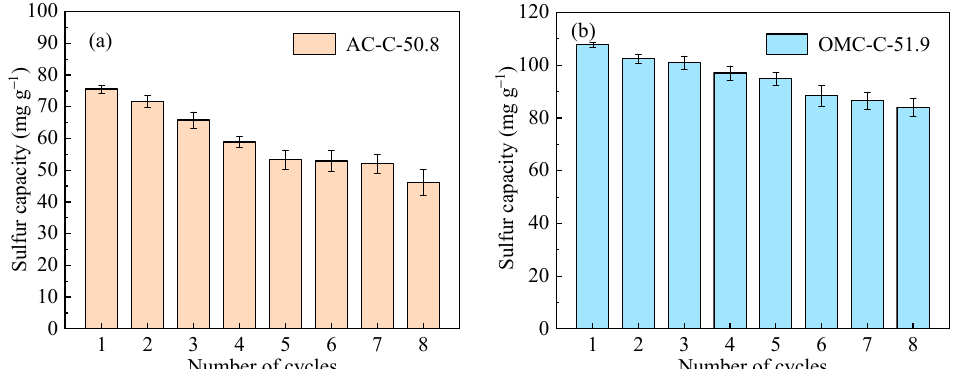
Figure 8. Sulfur capacity of the adsorbent over eight adsorption-regeneration cycles. ( a ) AC-C-50.8; ( b ) OMC-C-51.9. Adsorption conditions: 2.5 g of adsorbents, 1500 ppm SO 2 , 5% O 2 , 10% H 2 O, N 2 balance, for 2 h, at 353 K. Regeneration time: 60 min.